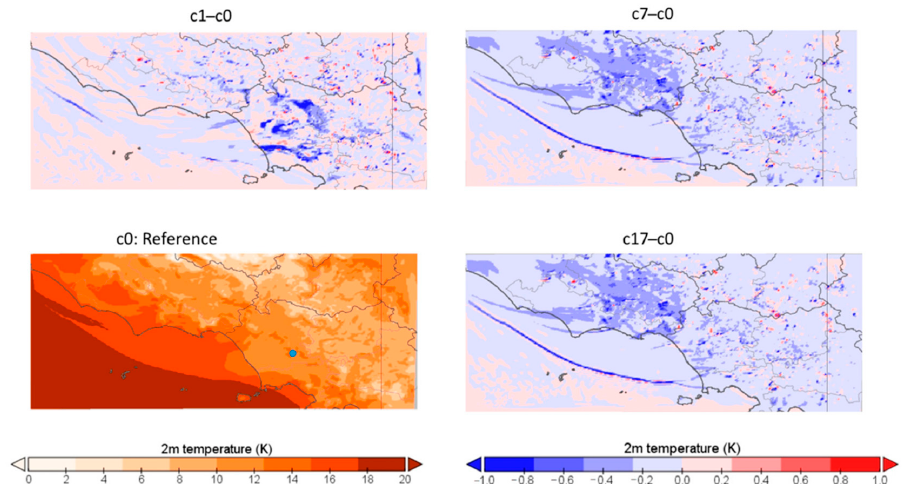
Figure 4. T2m distribution ( ◦ C) related to 5 November at 6.00 (hour 54) for configuration c0 (reference), and di ff erence of distributions obtained with configurations c1, c7, and c17 compared to the reference one. The CIRA site is identified by a blue dot.